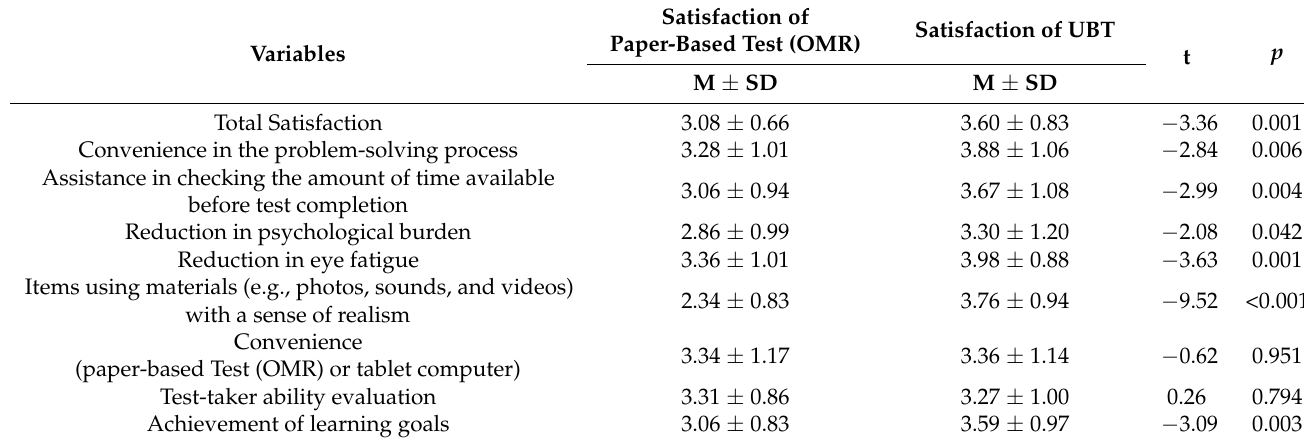
Table 3. Comparison of satisfaction with midterm paper-based test and final UBT ( n = 66).